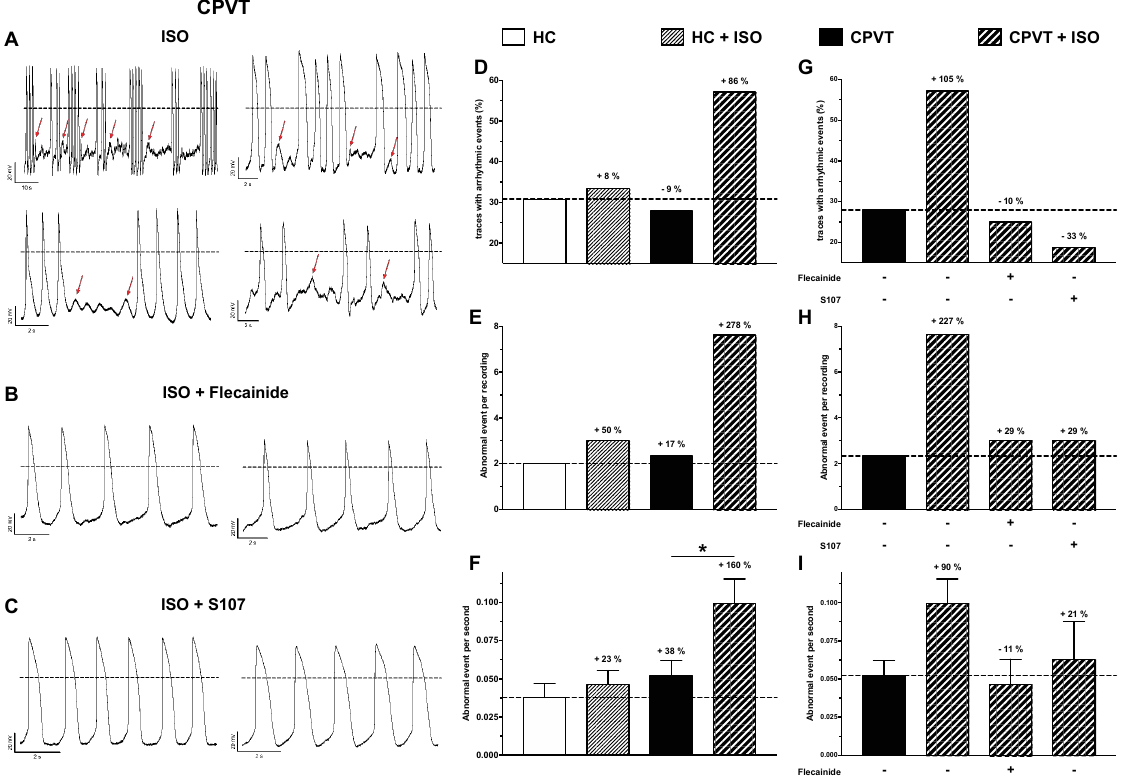
Figure 6. Abnormal electrical activity is elicited by ISO and normalized with flecainide and S107 treatments. ( A – C ) Examples of current clamp raw traces showing APs recorded from CPVT hiPSC-CM after treatment with ISO (1 µ M) ( A ), flecainide (5 µ M) + ISO ( B ) and S017 + ISO (5 µ M) ( C ). ( D – F ) HC and CPVT abnormal electrical activity is studied with and without ISO (HC: n = 26, HC + ISO: n = 20, CPVT: n = 41, CPVT + ISO: n = 29). Percentages of variations are indicated in comparison with HC. ( G – I ) The effect of flecainide ( n = 12) and S107 ( n = 16) pre-treatment (indicated by the + in contrast to -) on CPVT hiPSC-CM is also studied. Abnormal electrical activity is evaluated through the measure of the number of trace with aberrant events ( D , G ), the measure of abnormal event in each recording showing at least 1 abnormal event ( E , H ) and their frequency in Hz ( F , I ). * p < 0.05.